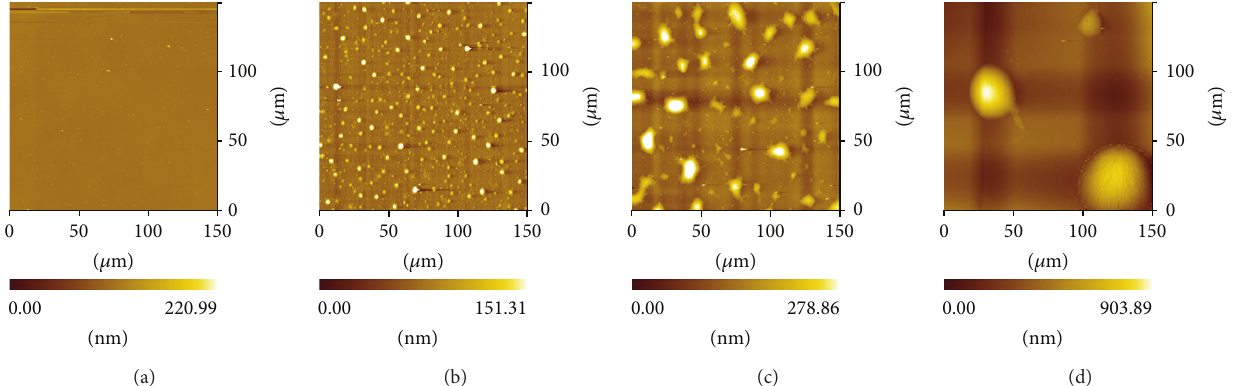
Figure 2: AFM topographies of PEO- b -PS film after annealing for 8h at 393 K with initial thickness of (a) 5.8nm, (b) 10.7nm, (c) 25.6 nm, (d) 43.9 nm.